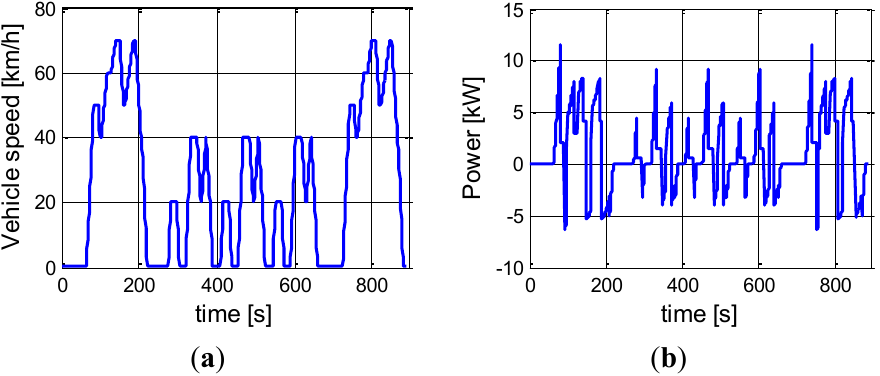
Figure 8. Japanese 10-15 driving cycle ( a ) and required output power ( b